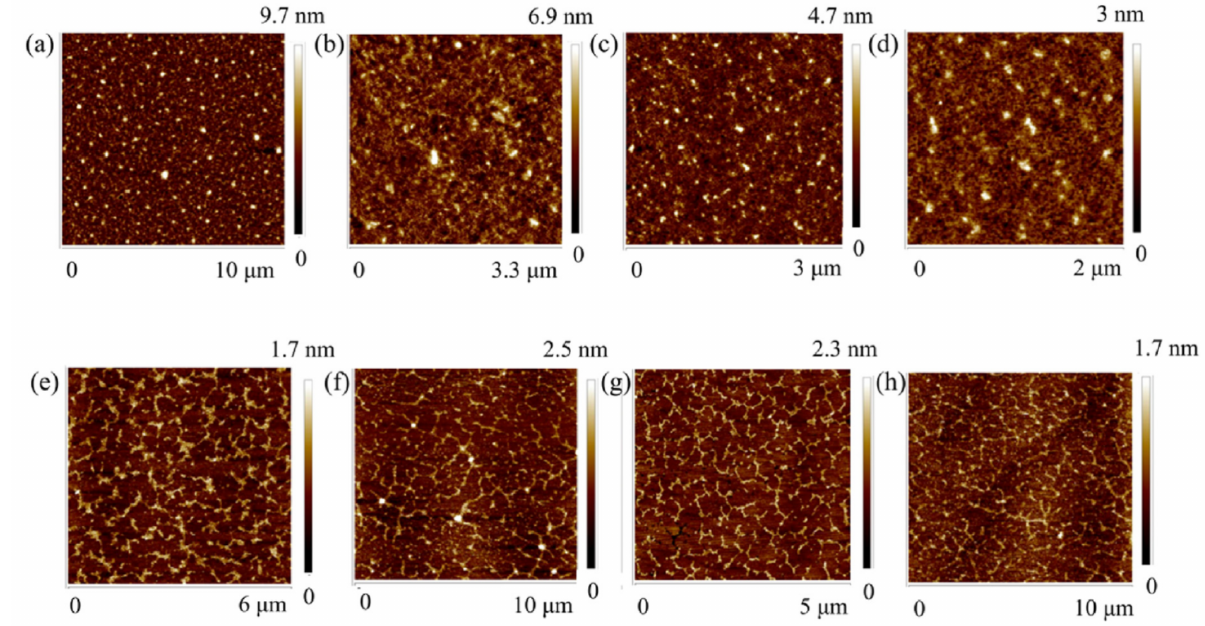
Figure 9. AFM images of polysaccharide extracts from Euchema , mostly containing ι -carrageenan. Extraction conditions/temperatures were: ( a ) 0.02 mg/mL 60 ◦ C extract; ( b ) 0.02 mg/mL 70 ◦ C extract; ( c ) 0.02 mg/mL 80 ◦ C extract; ( d ) 0.02 mg/mL 90 ◦ C extract; ( e ) 0.002 mg/mL 60 ◦ C extract; ( f ) 0.002 mg/mL 70 ◦ C; ( g ) 0.002 mg/mL 80 ◦ C extract; and ( h ) 0.002 mg/mL 90 ◦ C. Reprinted from [136]. Copyright (2020), with permission from